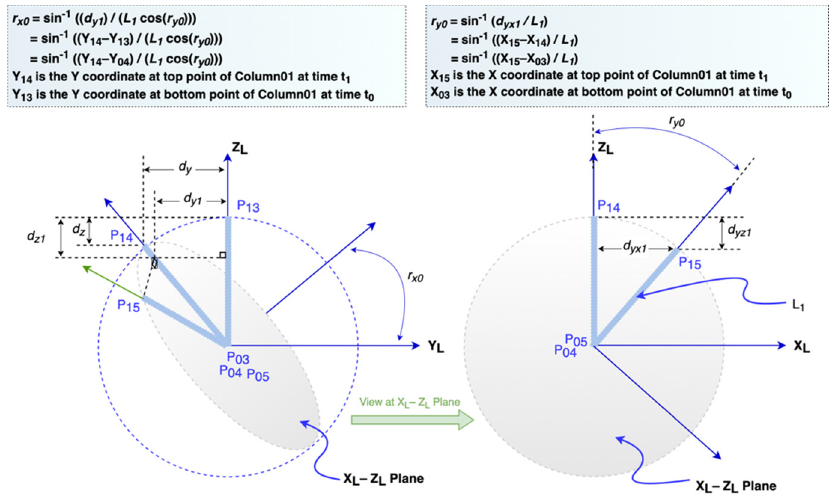
Figure 5. The rotation rx0 and ry0 at the Column01.